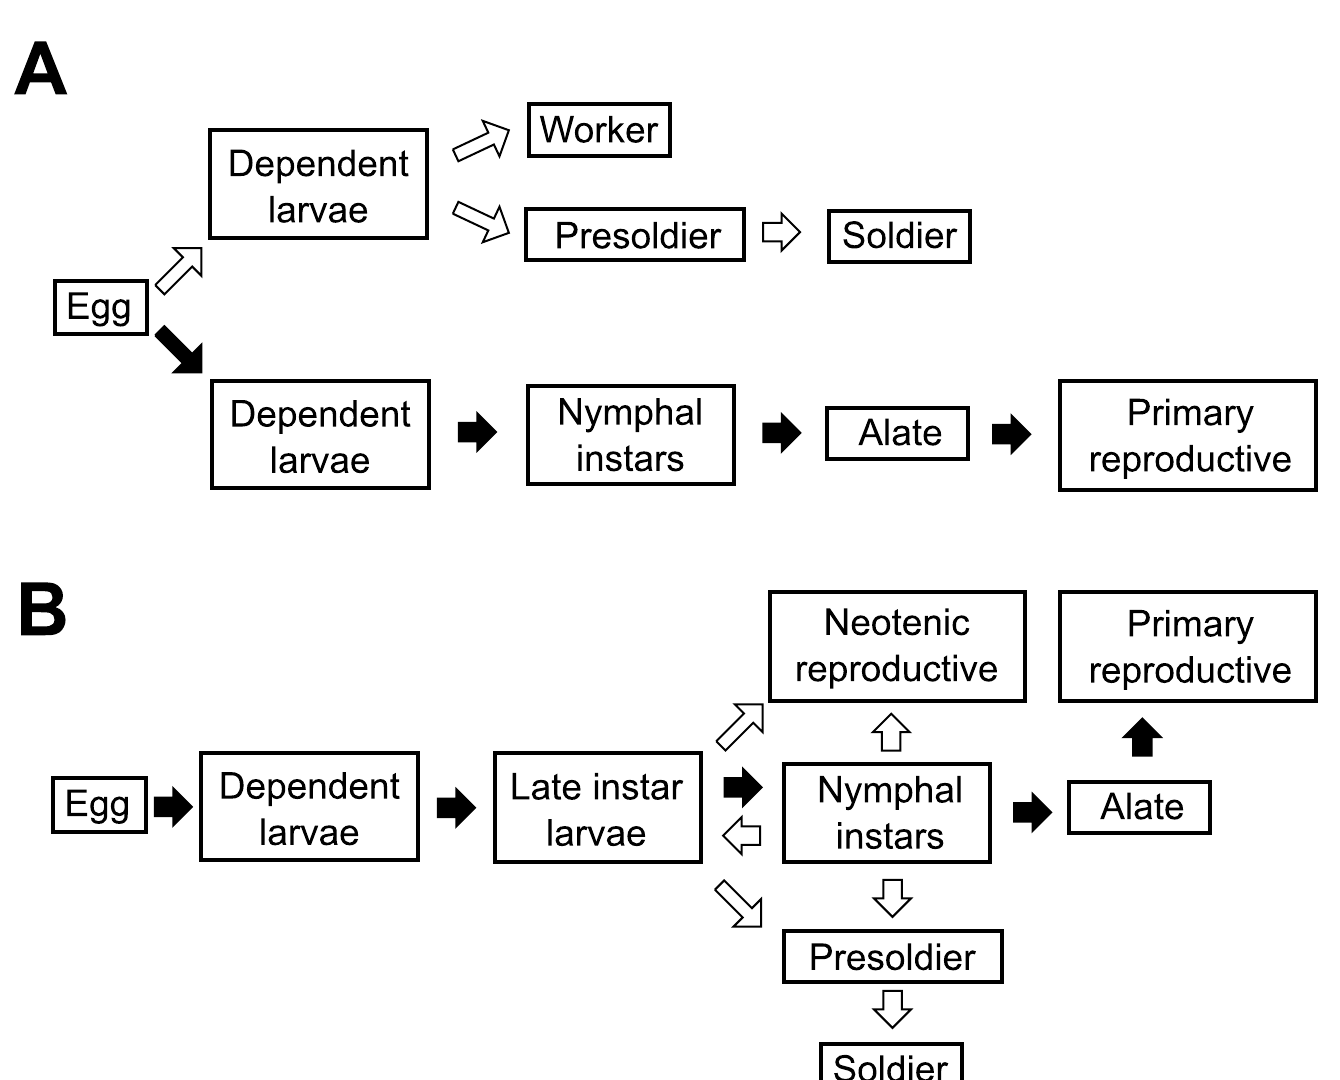
Fig 1. Developmental pathways in termites. Developmental pathways in termites with different degrees of sociality. (A) Typical developmental pathway for a termite with high degree of sociality, e.g. Macrotermes bellicosus (foraging termites). The development is less flexible and the immature workers are not totipotent. Early on during development (here in the egg stage) caste fate is determined. Individuals can either develop along the apterous line into workers and soldiers or along the nymphal line into primary reproductives. Arrows indicate the transition of one stage to another; in white: the default nymphal line which occurs in all insects, in black: deviations from these trajectories, specific to termites. (B) Typical developmental pathway for a termite with low degree of sociality, e.g. Cryptotermes secundus (wood- dwelling termites). Termite workers are totipotent immatures that can develop into soldiers or two kinds of reproductives, primary or neotenic reproductives. They also can molt regressively (arrow pointing